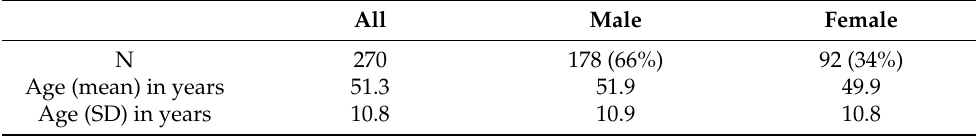
Table 1. Gender and age of